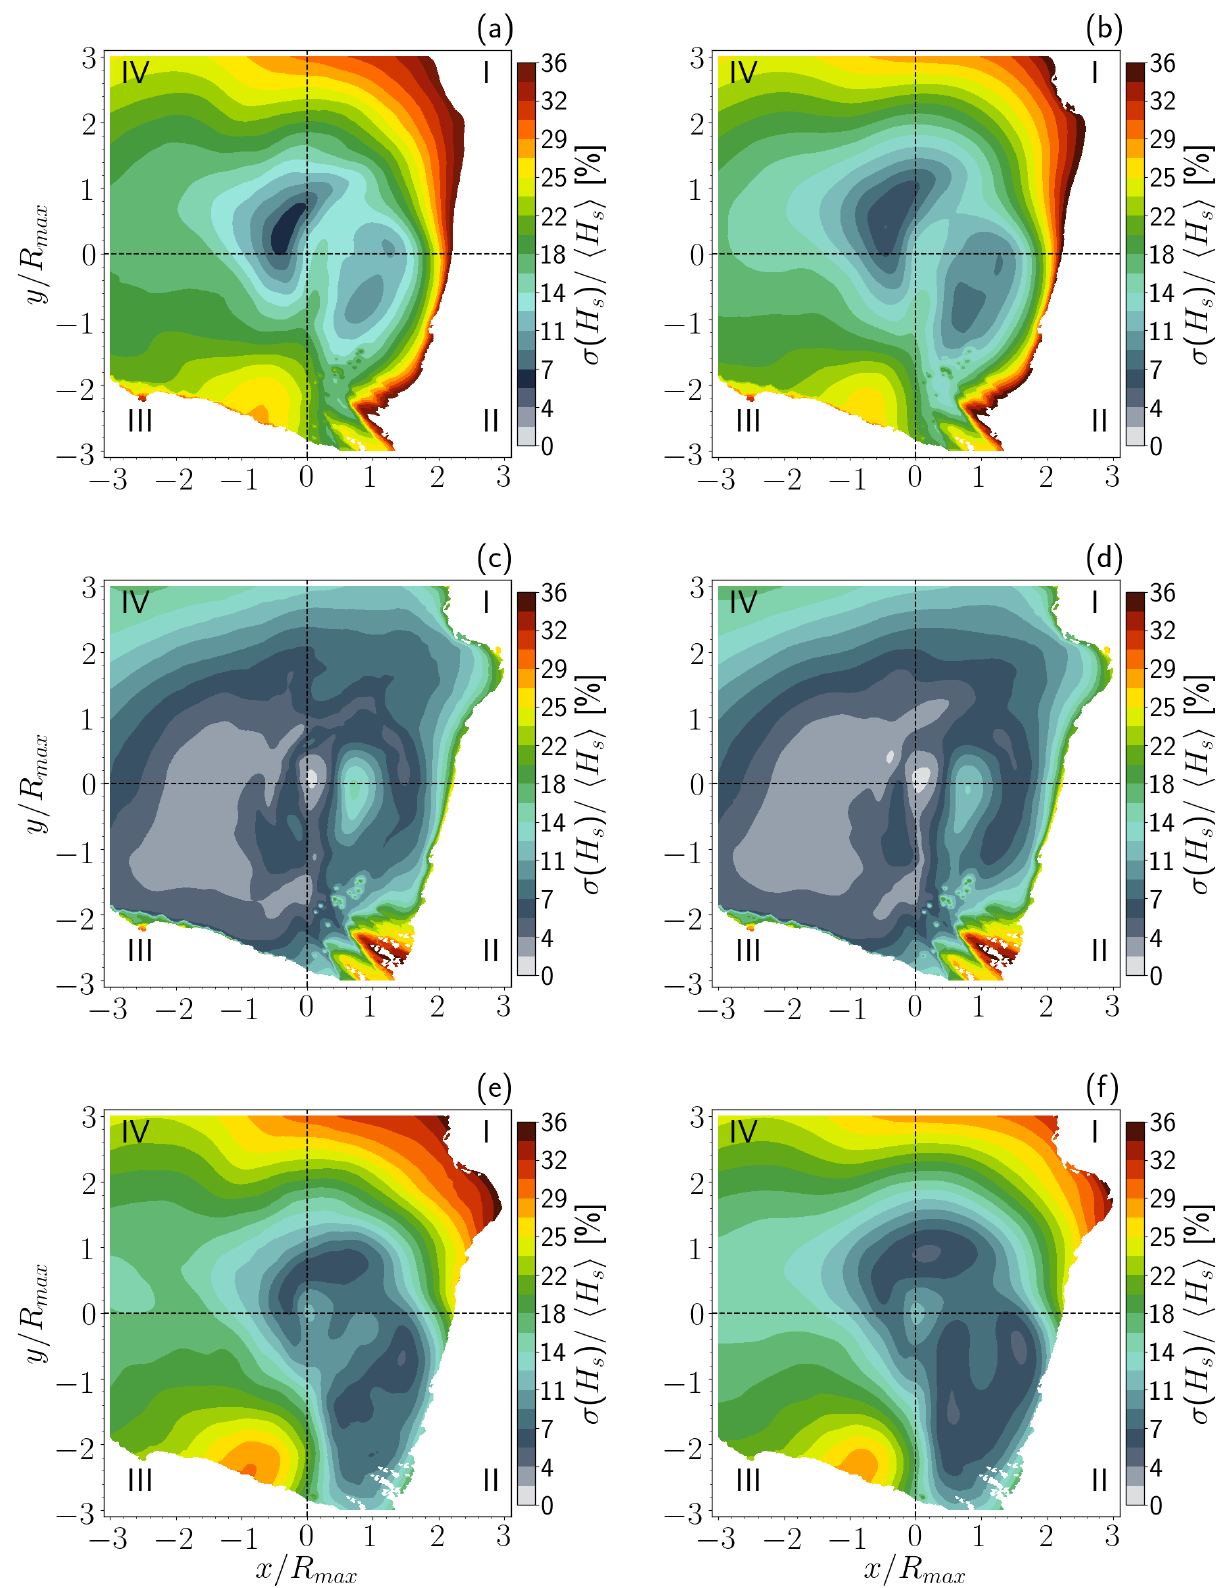
Figure 10. Temporal variability of the Hs field computed with the original ( left ) and filtered ( right ) data. The panel levels represent the 18 h scheme ( top ), moderate storm ( center ) and in- tensification ( bottom ) stages. ( a ) and ( b ) show the average for the total period (18 h); ( c ) and ( d ) show the period of moderate storm (9 h), and ( e ) and ( f ) show the intensification period (9